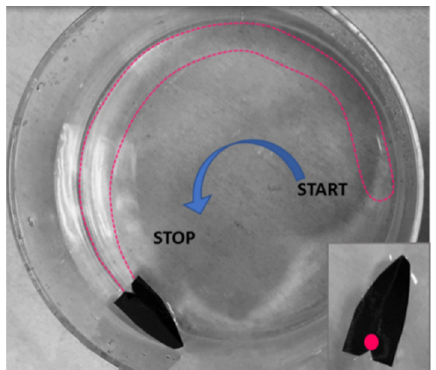
Figure 6. The dispensing of the polymeric droplet over the black boat floating on water induces the propulsion along the wall of the Becker and the simultaneous formation of a very thin semi-circular polymeric layer. On-the-fly formed polymer film is indicated by the dotted line.